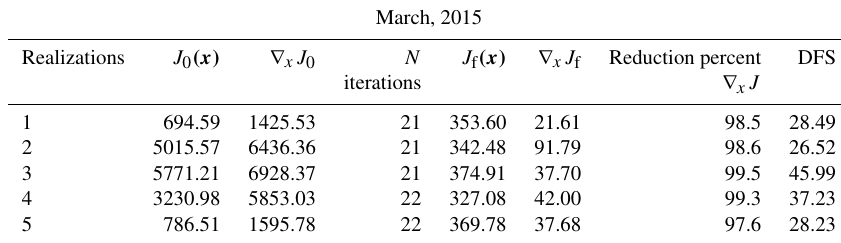
Table A2. Convergence diagnostic of the inversion system using an ensemble of five independent OSSEs for June 2015 ( ∇ x J 0 and ∇ x J 0 represent the initial cost function and its gradient at the beginning of the optimization and ∇ x J f and ∇ x J f are for the end of the optimization).